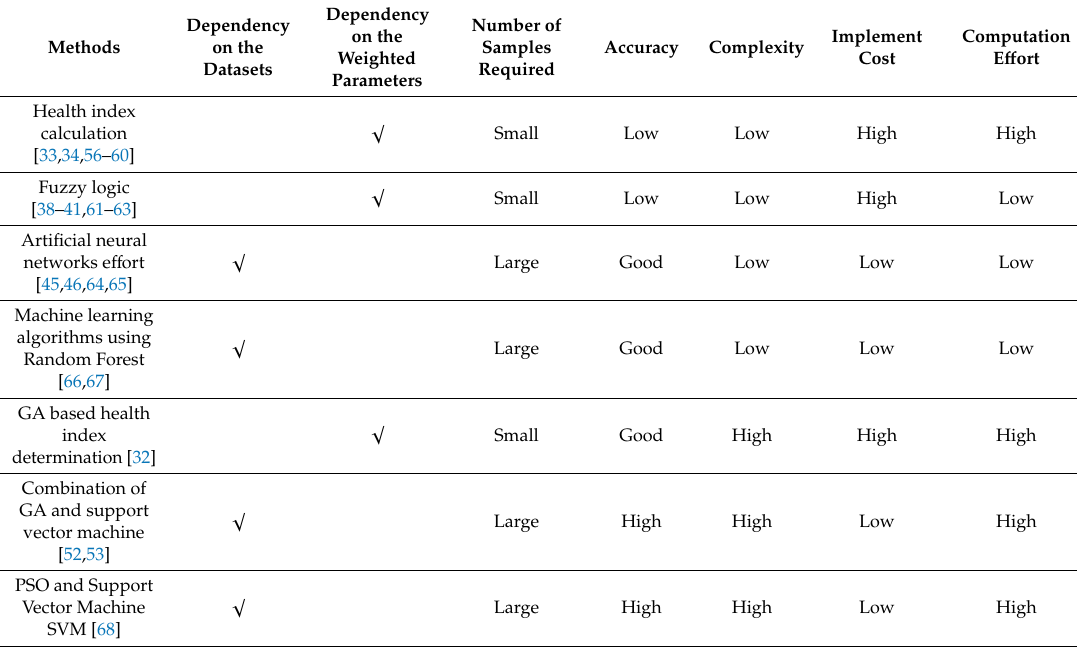
Table 3. Transformer health assessment methodologies